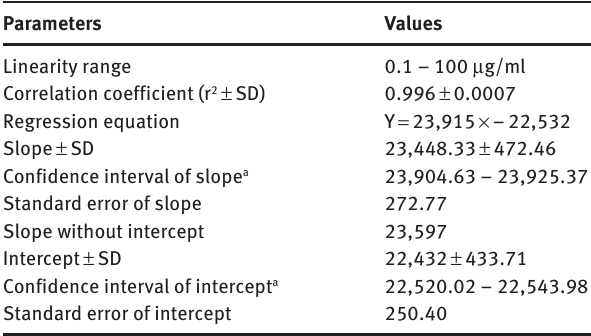
Table 1: Linear regression data for the calibration curves of rosuvastatin (n = 3).